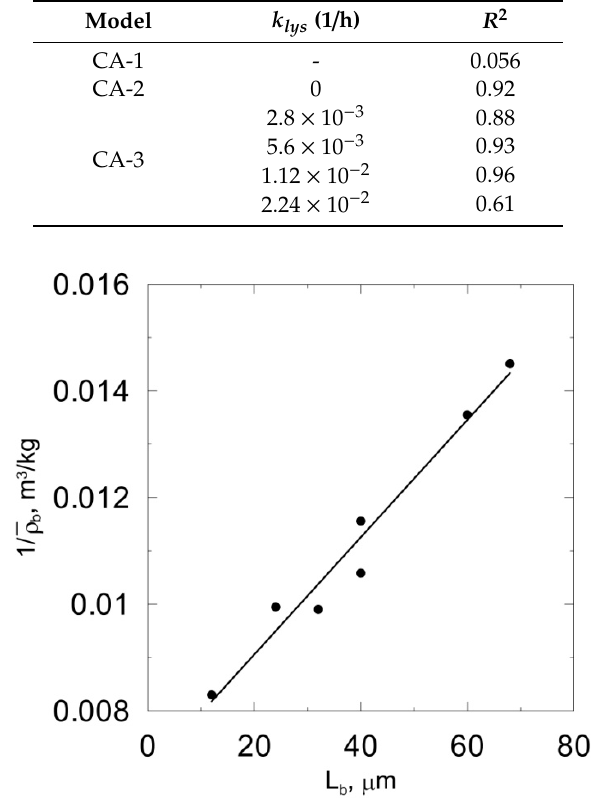
f L ρ = obtained using CA-3 model and k ρ = f ( L ) obtained using CA-3 model and k b b b b